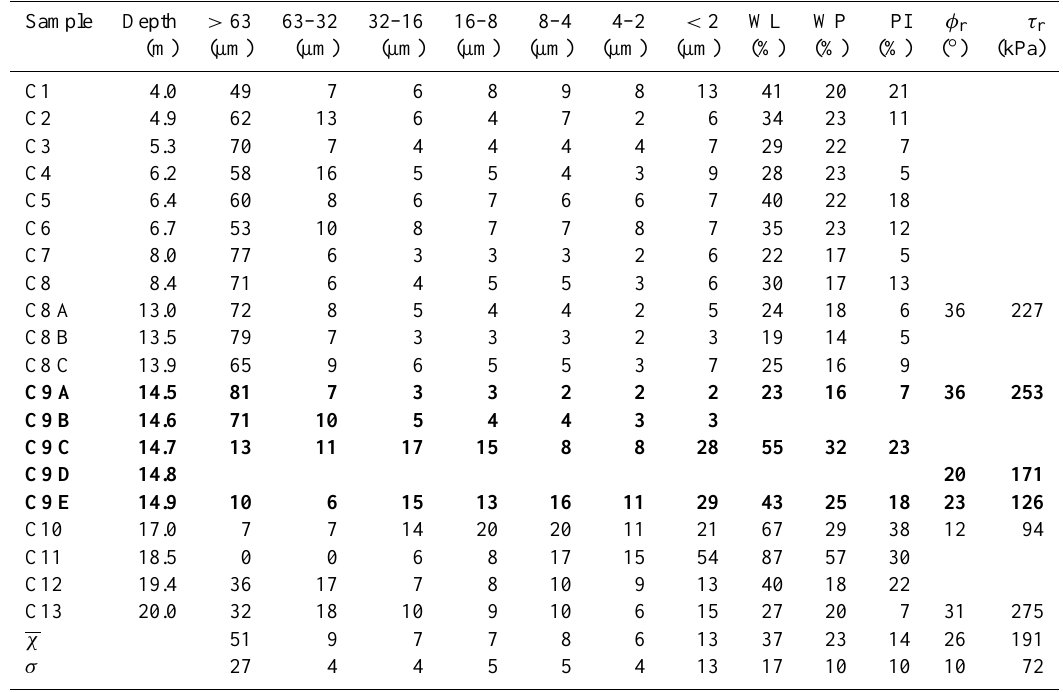
Table 1. Grain-size composition and geotechnical characters of analysed samples (WL = liquid limit; WP = plastic limit; PI = plastic index; ϕ r = residual friction angle; τ r = residual shear strength). Slip zone samples are reported in bold. Sample